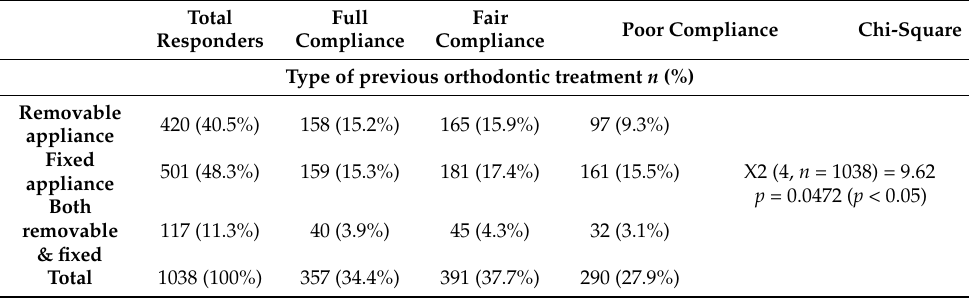
Table 6. Patient compliance and type of previous orthodontic